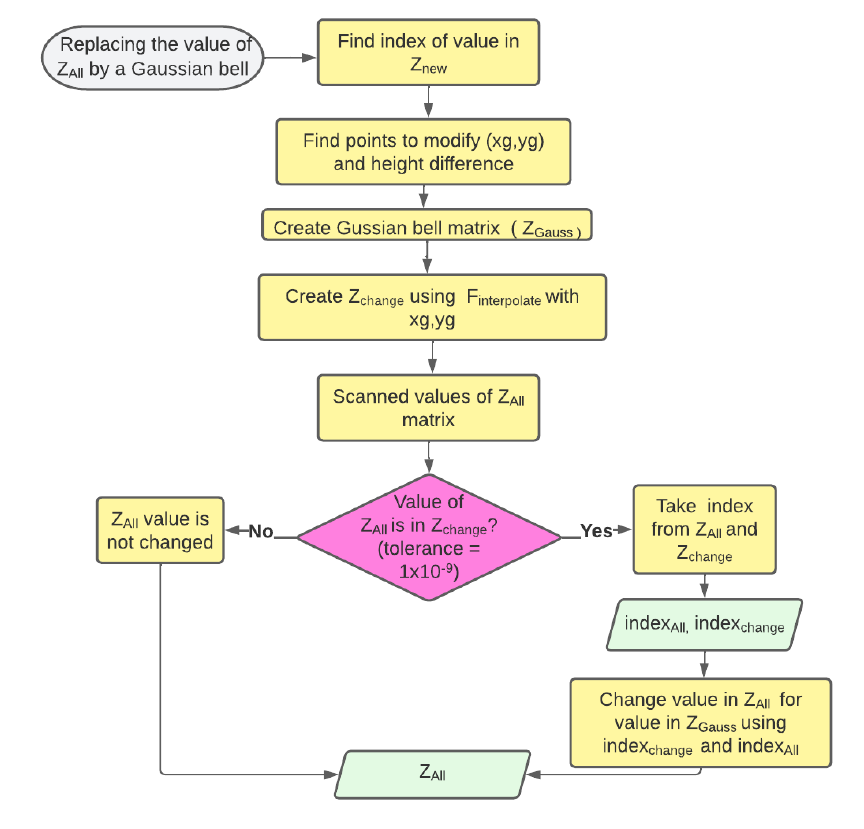
Figure 4. Flowchart 2, change of surface values using the Z Gauss and Z change matrices. Step 3 creates the matrix Z Gauss containing all the height values covering the Gaussian bell